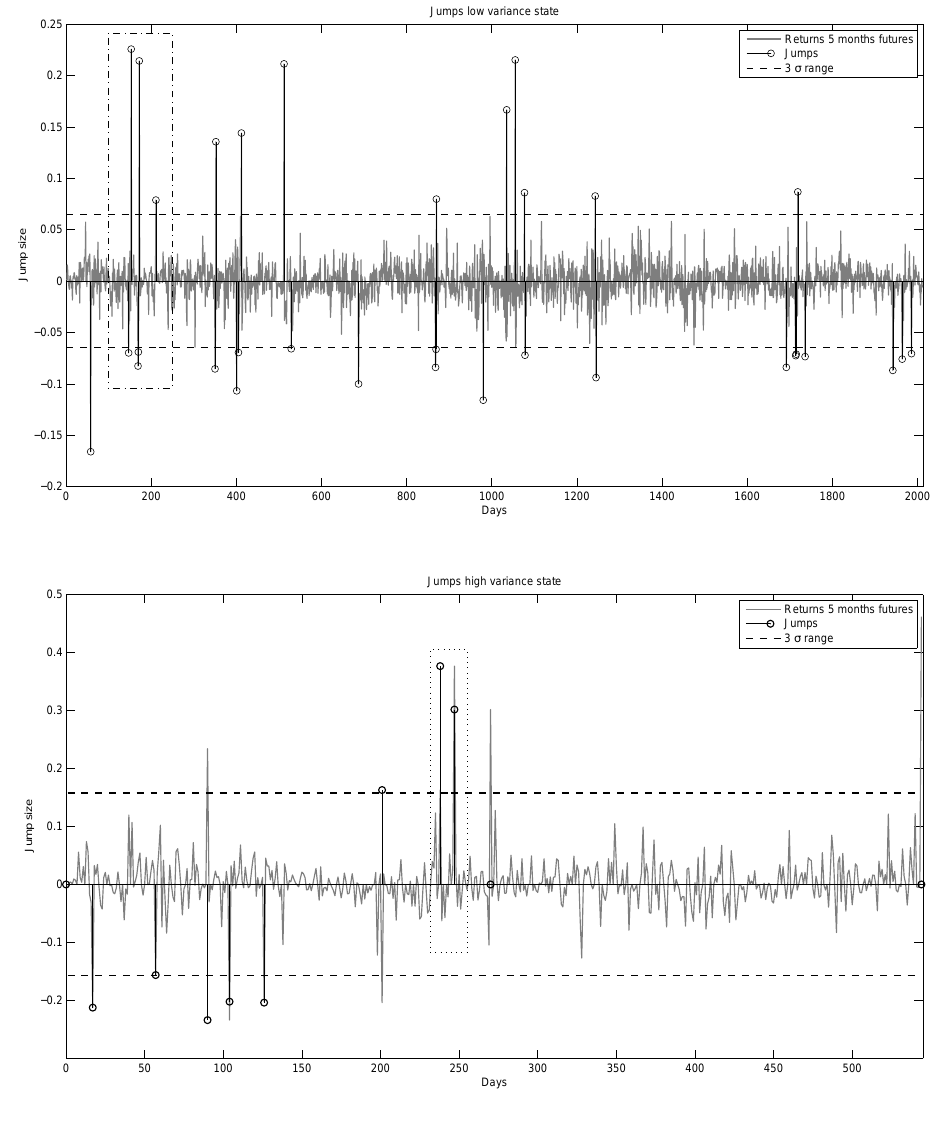
Figure 8. Jumps for the different